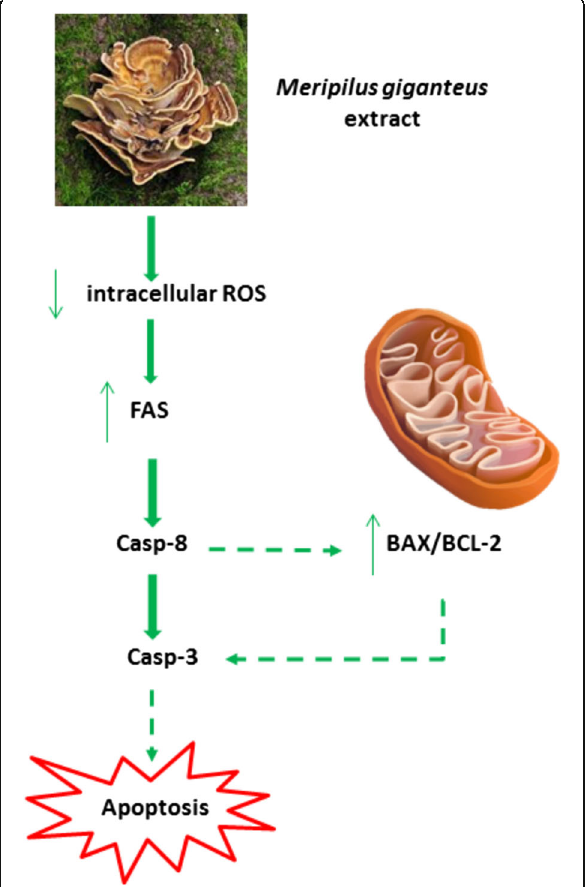
Fig. 10 Hypothesised pro-apoptotic mechanism of MG extract in leukemic cell lines. Due to its phenolic content and antioxidant activity, MG ethanolic extract induces a decrease of ROS intracellular level. In leukemic cell, ROS decrease has been related to FAS recruitment leading to the activation of the extrinsic apoptotic pathway. A possible explanation of the observed increase of BAX/ BCL-2 ratio consists in the fact that FAS ligands lead to apoptosis through caspase-8 activation which on one hand promote the extrinsic apoptotic pathway, while on the other promote mitochondrial membrane potential loss through BAX/BCL2 ratio